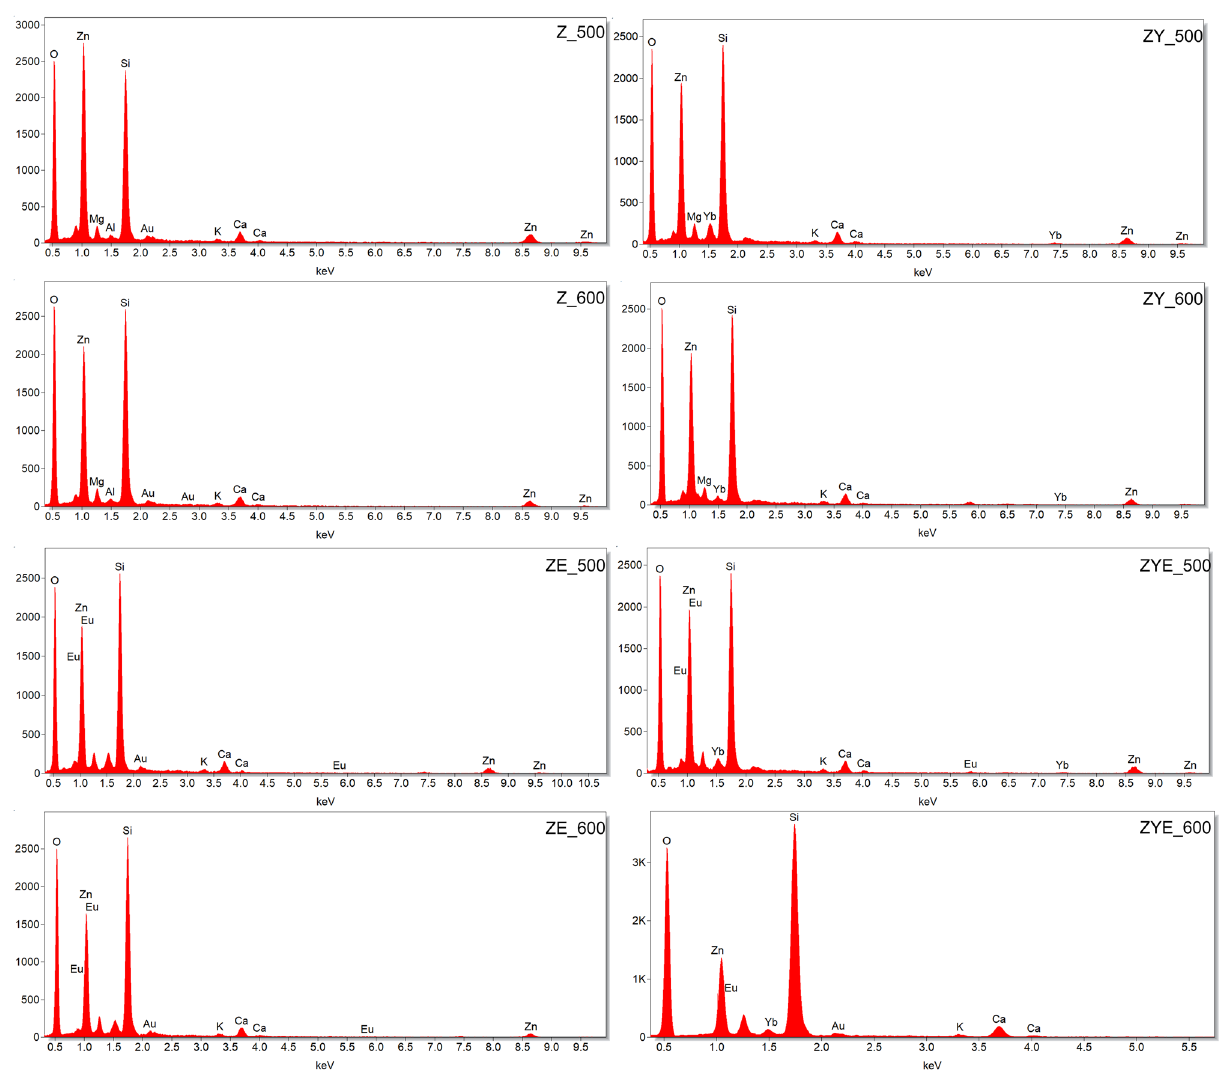
Figure 3. EDS analysis of ceramic hybrid thin films calcined at 500 and 600 ℃